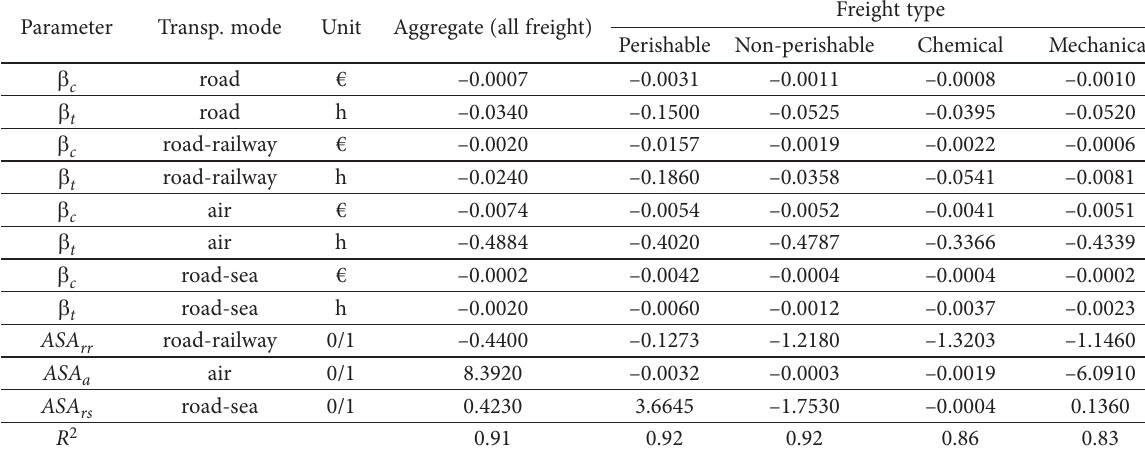
Table 10. Mode choice model for export calibration